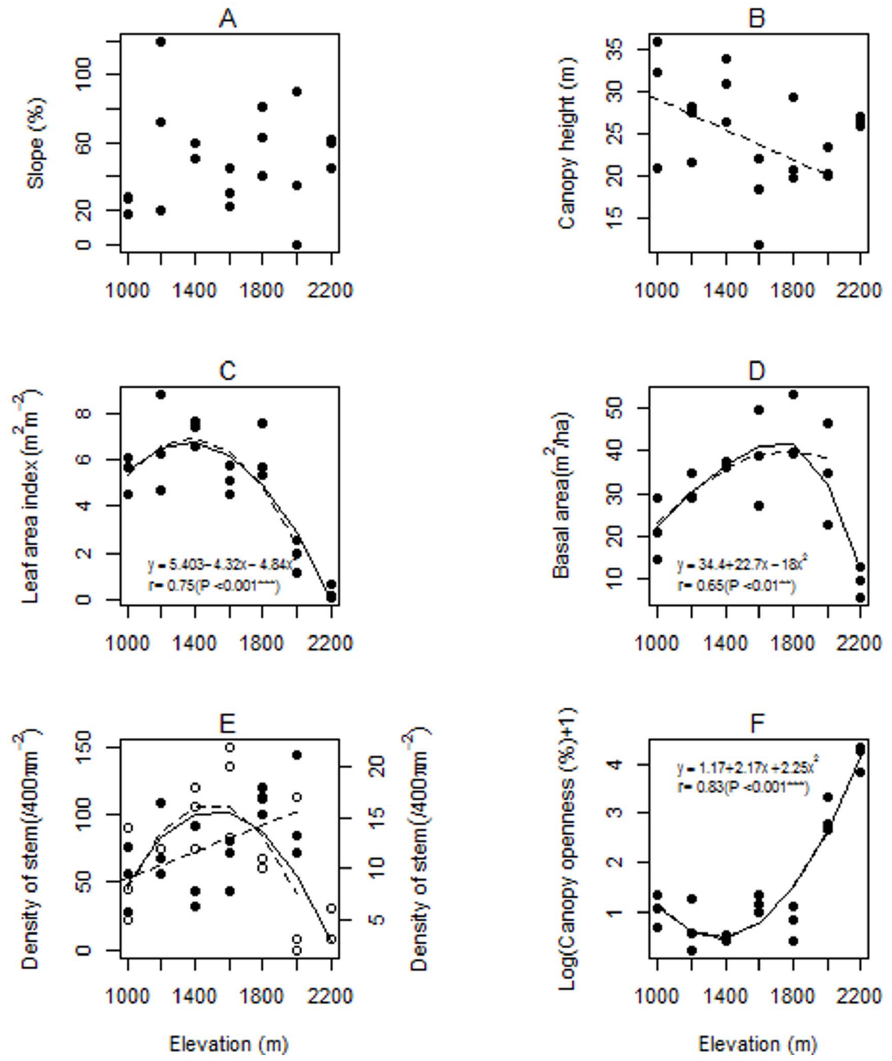
Figure 2. Relationships between elevation and slope, and between elevation and various components of forest structure on Mount Rinjani, Indonesia. A) slope, B) canopy height (y=38.19 + 0.01x, R 2 =0.21), C) LAI, D) basal area, E) tree density, where filled circles are for subcanopy trees (y-axis on left, y=3.68 + 0.05x, R 2 =0.25) and open circles are for canopy trees (y-axis on right, y=12.39-0.48x-14.62x 2 , R 2 =0.33), and F) canopy openness. Solid lines indicate relationships including all elevation stations and the dashed lines indicate the relationships when the station at 2200 m (fire-maintained grassland) was omitted. Only significant ( p , 0.05) relationships are shown. The non-zero woody biomass and canopy height for the grassland station (2200 m) are because there were small numbers of isolated trees.